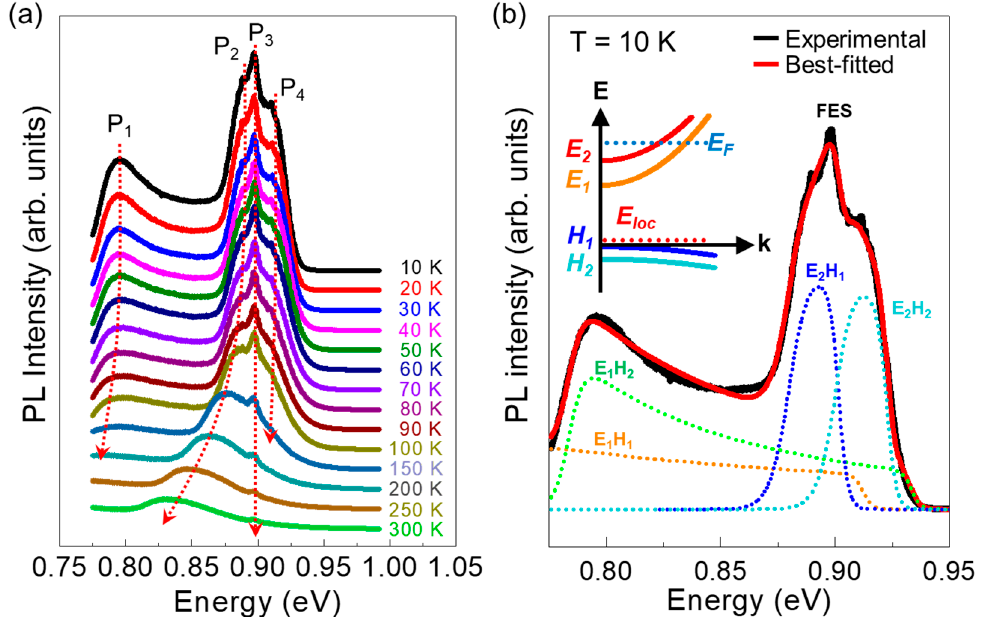
Figure 2. ( a ) Temperature-dependent PL spectra of the molecular beam epitaxy (MBE)-grown In 0.53 Ga 0.47 As/In 0.52 Al 0.48 As QW at 10–300 K. ( b ) Deconvoluted PL spectra at 10 K obtained by using the localization energy state-included line-shape fitting model. The inset illustrates the in-plane energy band scheme presented in the k-space.